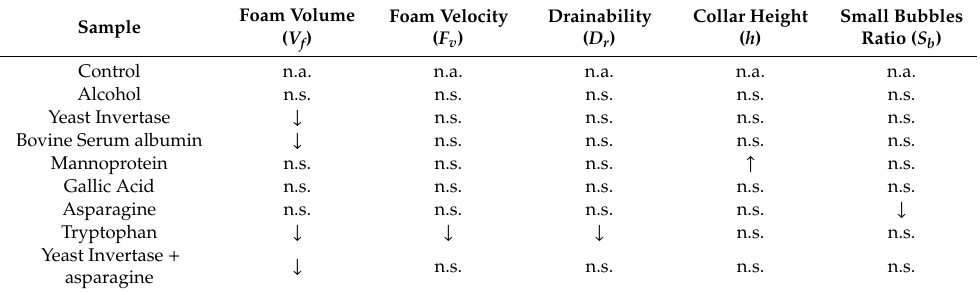
Table 2. Foam parameters analysed showing significant increase ( ↑ ) or decrease ( ↓ ).